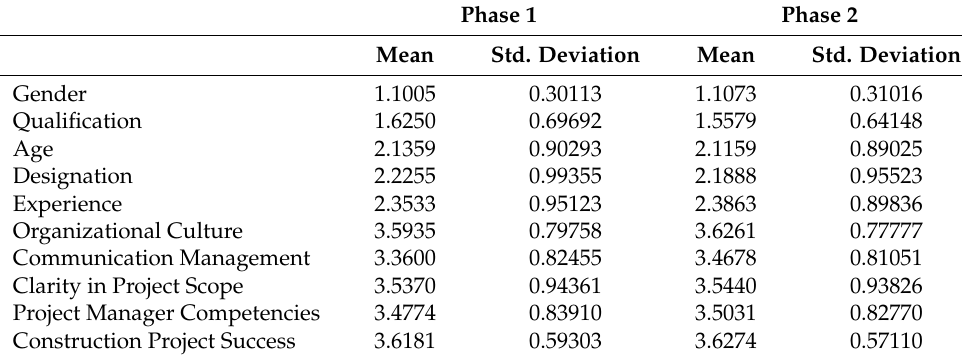
Table 3. Mean and std.